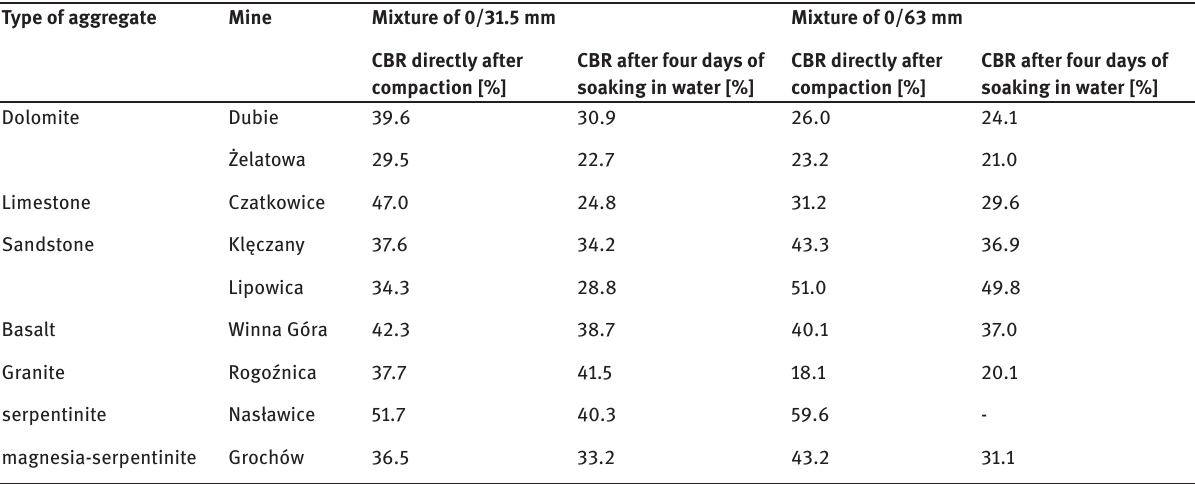
Table 4: Values of CBR ratio for mixtures after compaction and after four days of soaking in water. Type of